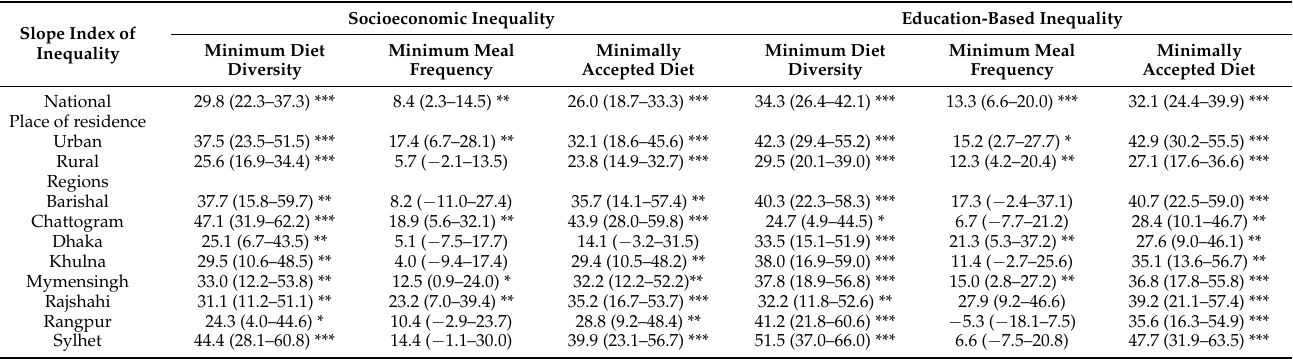
Table 2. Socioeconomic and education-based absolute inequalities in minimum diet diversity, mini- mum diet frequency and minimally accepted diet among Bangladeshi children aged 6–23 months (N =